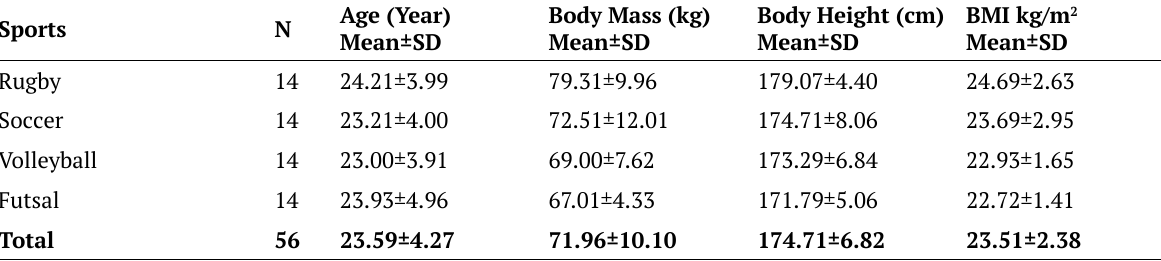
Table 1. Anthropometric characteristics among Athletes from Random Intermittent Dynamic Type